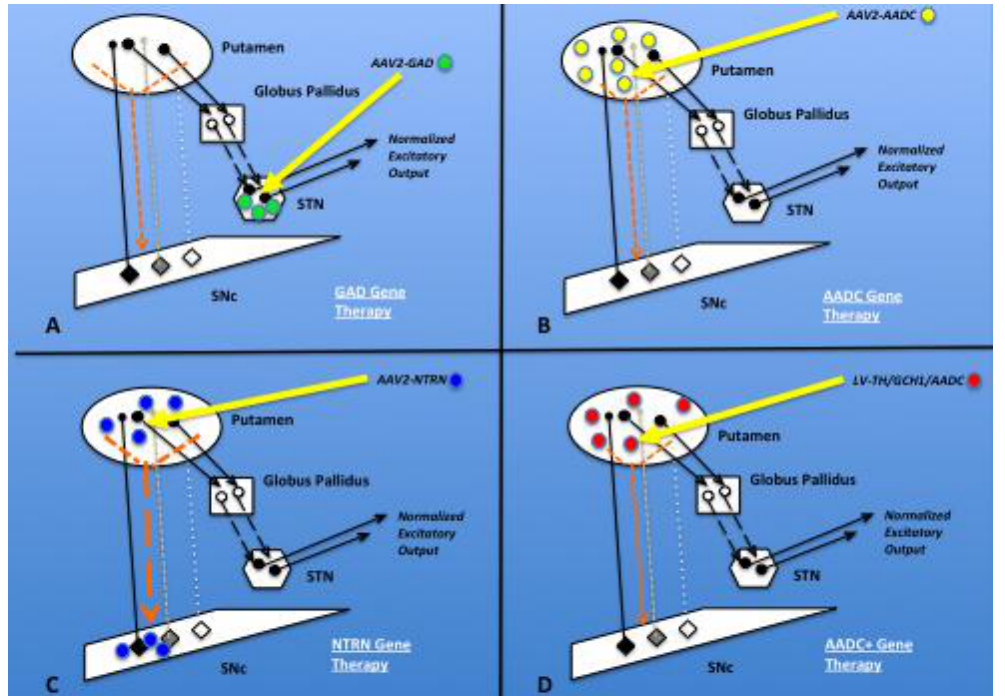
Figure 2. Current gene therapy treatments for PD. In each panel ( A–D ), the nigrostriatal (NS) neuron cell bodies (diamond shapes) are shown within the substantia nigra pars compacta (SNc), with normal (black), degenerating (gray), and degenerated (white) perikarya and axons projecting to the putamen. The reciprocal striatonigral pathway is depicted (orange dashed arrow). Typically, NS dopaminergic (DAergic) neurons (black diamond) influence putamenal neurons. Excitatory putamenal neurons (black circles and arrows) project to the globus pallidus, where inhibitory neurons (white circles and arrows) are activated. Inhibitory tone from the globus pallidus suppresses excitatory output from the subthalamic nucleus (STN), and thereby maintains normal motor control. In PD, the loss of excitatory DAergic input to the putamen, therefore leads to a relative increase output from the STN, leading to motor dysfunction. ( A ) GAD gene therapy. Stereotactic delivery (yellow arrow) of AAV2-GAD (green circle) into the bilateral STN allows increased local GABA production, thereby inhibiting excitatory STN output and improving motor system dysfunction; ( B ) AADC gene therapy. AAV2-AADC (yellow circle) delivery to the bilateral putamen replaces lost AADC. Re-establishing the DAergic stimulation of striatal neurons helps normalize the motor feedback loop through globus pallidus and STN; ( C ) NTRN gene therapy. AAV2-NTRN (and GDNF) (blue circle) delivery provides local production of NTRN and enhances residual DAergic cell function within the putamen. Retrograde transport of AAV2-NTRN within residual intact DAergic nigral neurons, as well as anterograde transport of AAV2-NTRN via the striatonigral pathway (dashed orange arrow) to the SNc, further improves DAergic neuronal function and survival. Injection of vector into SN is not shown but would increase the amount of AAV2-NTRN within the SN, independent of the anterograde transport pathway; ( D ) AADC+ gene therapy. Lentiviral (LV) vector delivery, carrying the tripartite gene construct for the dopamine biosynthetic enzymes (TH/GCH1/AADC) (red circle), allows restoration of excitatory DAergic tone within the